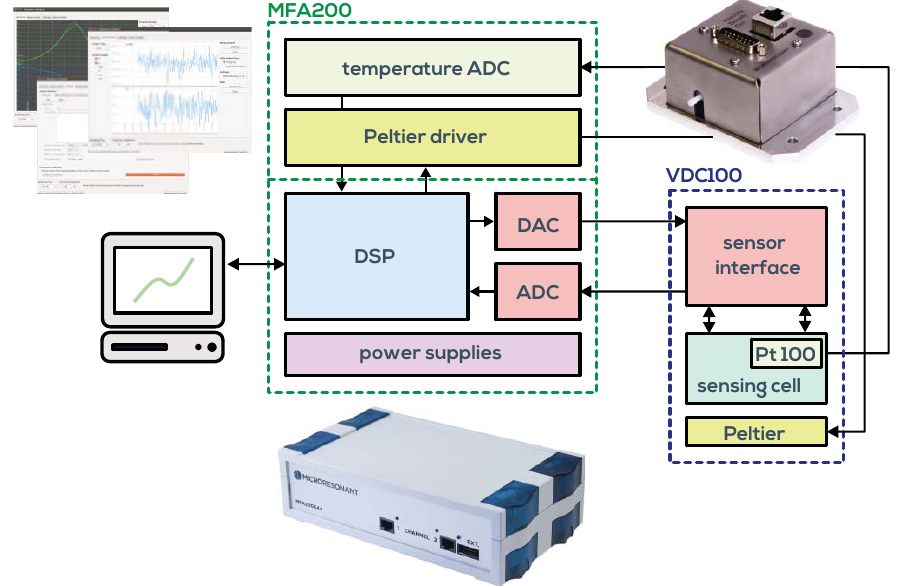
Figure 6. Schematic of the measurement system. The viscosity-density cell VDC100 is connected to the universal resonance analyzer MFA200. The graphical user interface suite of the MFA200 is used for test cycle automation and post